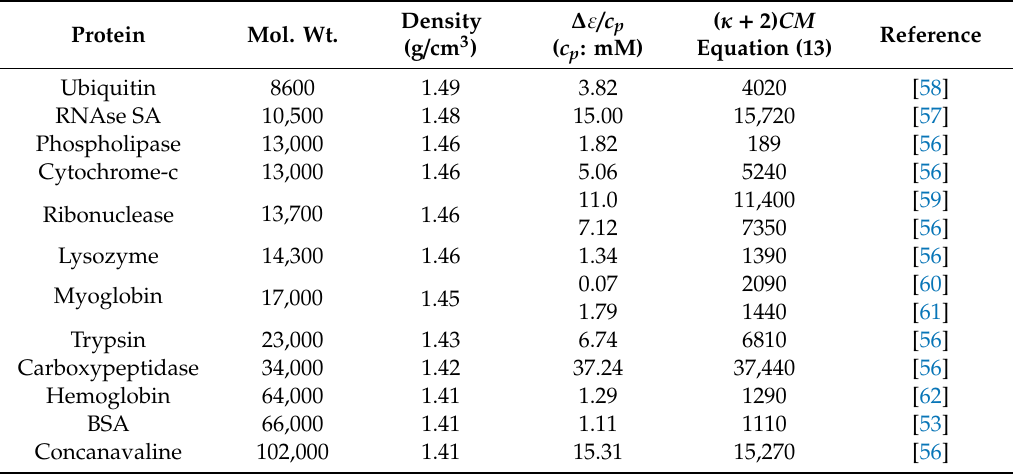
Figure 9. Schematic of a ‘Russian doll’ model for a protein with a permanent dipole moment M p , which occupies the innermost cavity together with its strongly bound water molecules. The protein’s dipole field extends beyond an outer macroscopic, ‘mathematical’, surface where the classical boundary conditions of electrostatics can be applied. Within this mathematical surface is a boundary that contains the protein’s outer hydration sheath, and the hydrodynamic plane of shear that defines the zeta-potential within the protein’s di ff use electrical double-layer. Table 1. Values of the factor ( κ + 2) CM given by Equation (13) for various globular proteins, derived from reported ∆ ε and corresponding protein concentration values. The protein density values were derived from the weight-depending function given by Fischer et al. [55]. Protein Mol.